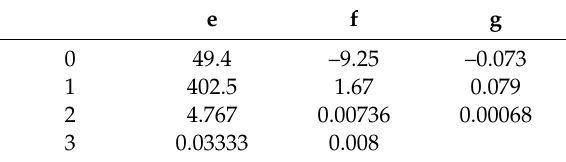
Table 1. The values of coe ffi cients in formulas approximating water